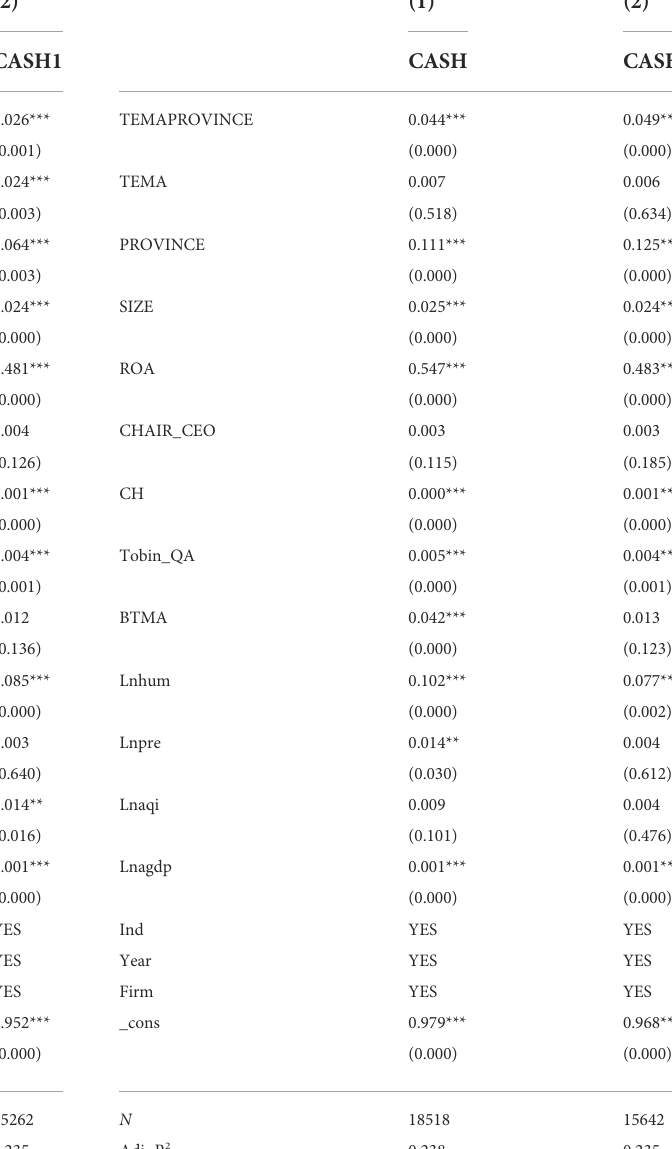
TABLE 13 Climate change, ecological vulnerability zoning, and corporate cash